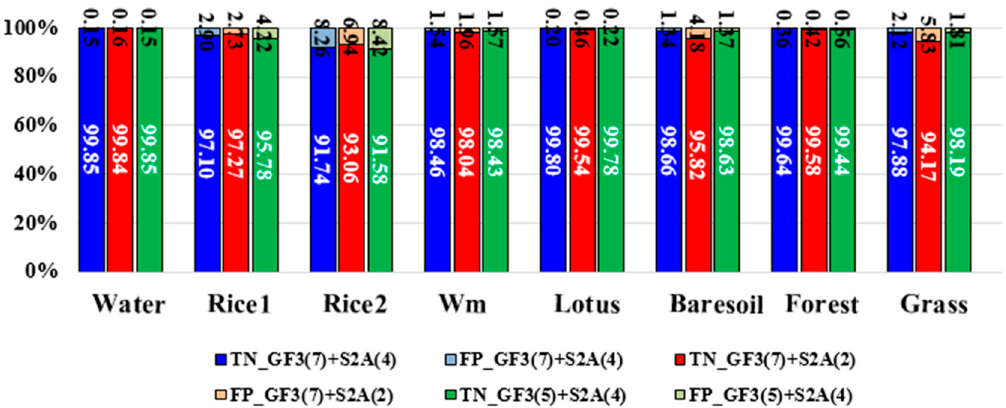
Figure 11. The true negative (TN) rates and the false positive (FP) rates of different land covers generated from different combination of features. Wm means watermelon.